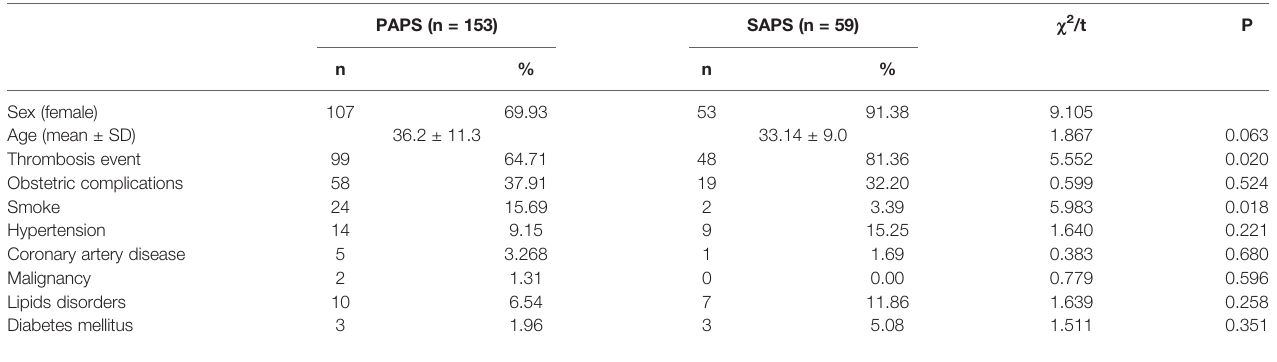
TABLE 2 | Demographic and clinical characteristics of the 153 PAPS and 59 SAPS